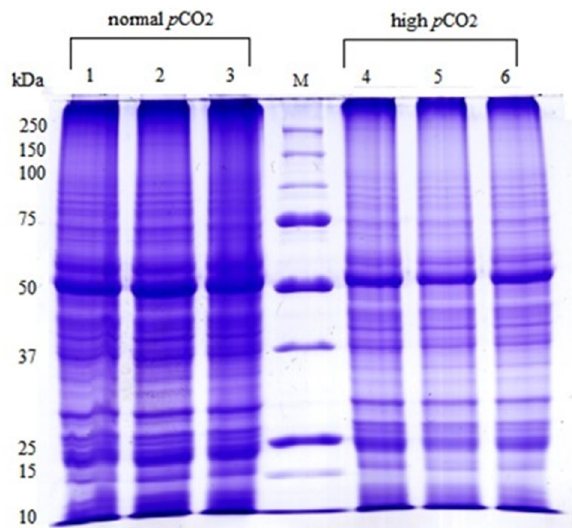
Figure 1. 1D-SDS PAGE of proteins from leaves of three biological replicates of Cymodocea nodosa living in normal (lanes 1,2,3) and in high (lanes 4,5,6) p CO 2 environments in Vulcano Island. 25 μg of proteins in each well were loaded. Markers used from Bio-Rad 250–10